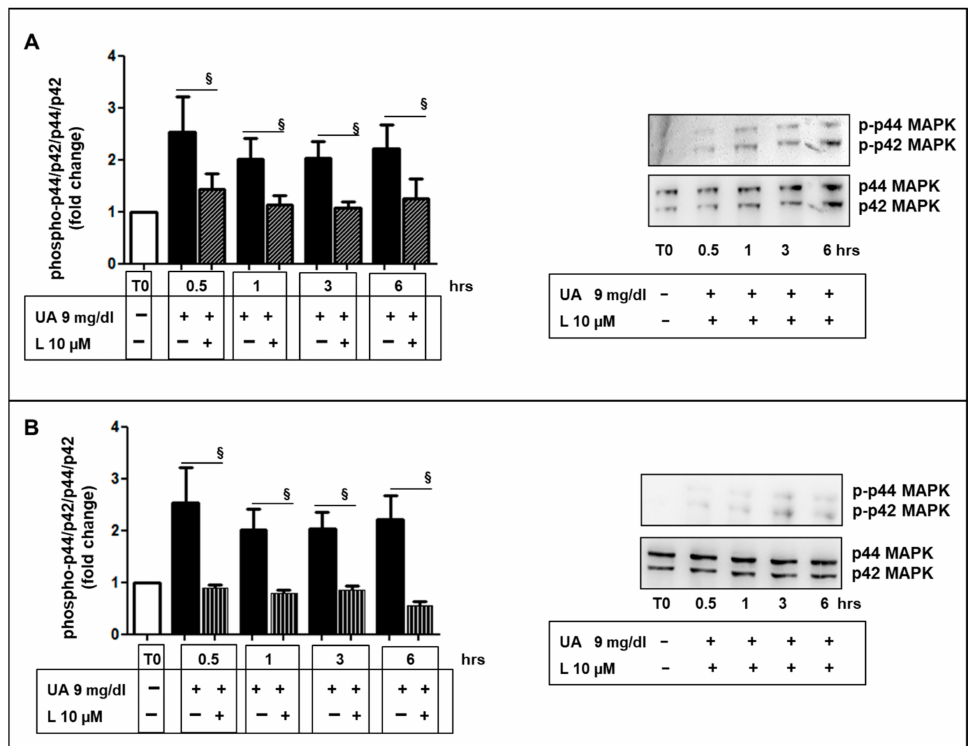
Figure 10. ARBs inhibited UA-mediated p44/42 MAPK activation. ( A ) L and ( B ) V inhibited p44/42 MAPK phosphorylation in MOVAS exposed to UA 9 mg/dL. The graphs represent relative phospho- p44/42 MAPK protein abundance normalized to p44/42 MAPK and data are expressed as fold change with respect to T0 and significance is expressed vs. UA treated cells at the same time and as means ± SEM of three independent experiments. § p < 0.05 vs. UA. ARBs = Angiotensin Receptor Blockers; L = Losartan; V = Valsartan; UA = Uric Acid; MAPK = Mitogen-activated protein kinase;T0 = Time 0; hrs. =